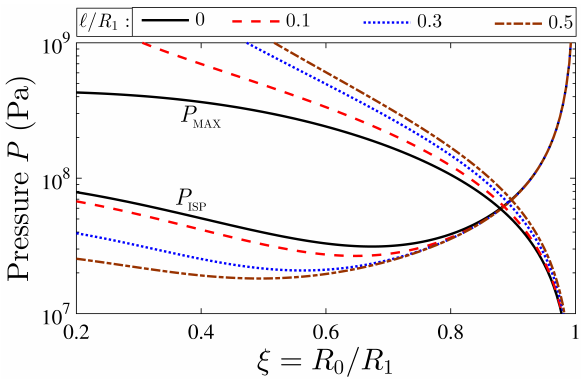
Figure 8: Stress gradient effects on the functions P ISP ( ξ ) and P MAX ( ξ )